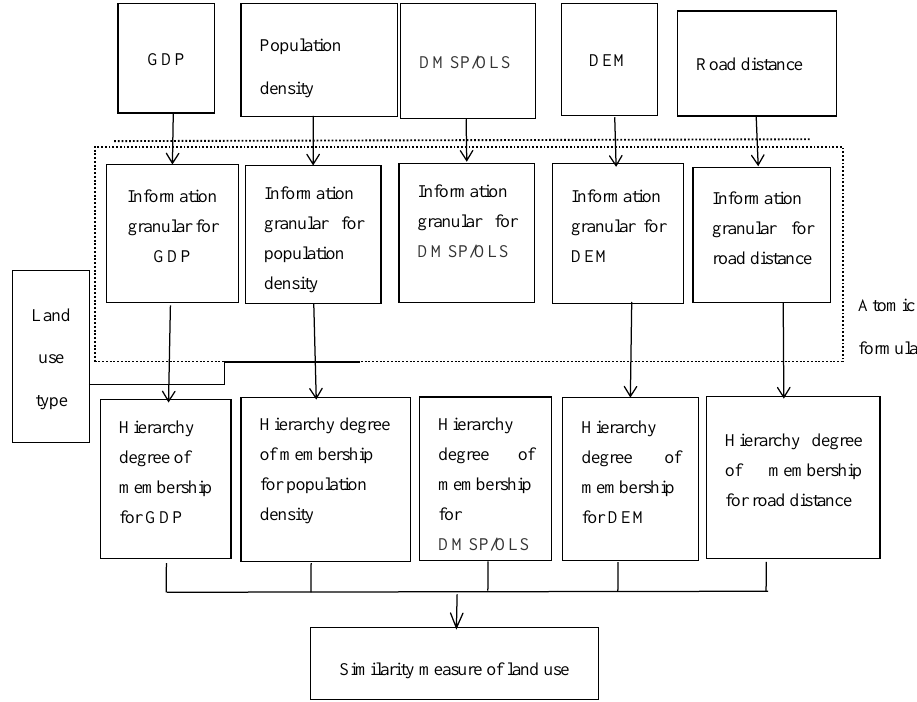
Figure 5. Computing framework for the similarity measures of land use change types in Guangxi based on granular computing closeness. Table 2. Land use type area in 2010 (unit: km 2 ).